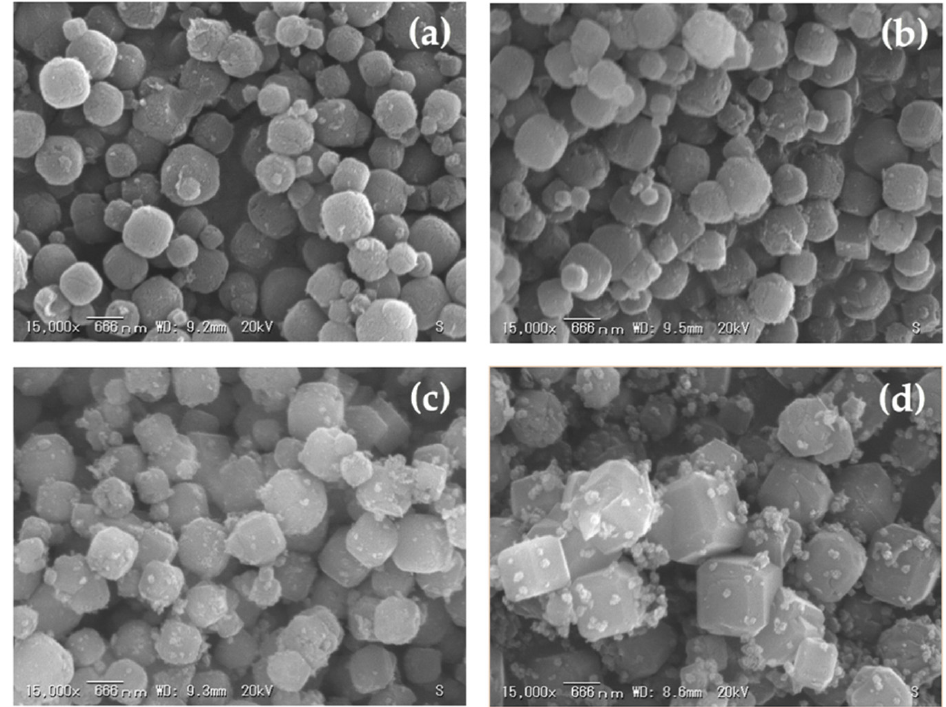
Figure 10. Morphologies of synthesized zeolite A with a curing time of 6.0 h and related phases achieved using different corn stover ash:NaOH ratios ( a ), corn stover ash:NaOH = 1:0.5, ( b ) corn stover ash:NaOH = 1:1.0, ( c ) corn stover ash:NaOH = 1:1.5, ( d ) corn stover ash:NaOH = 1:2.0.